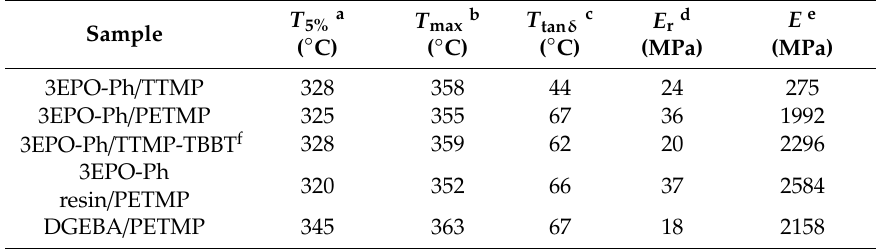
Figure 6. DTG curves under N 2 at 10 °C/min of the materials obtained from the phloroglucinol derivative with different thiols. Table 3. Thermal and thermomechanical data of the thermosets prepared from 3EPO-Ph.